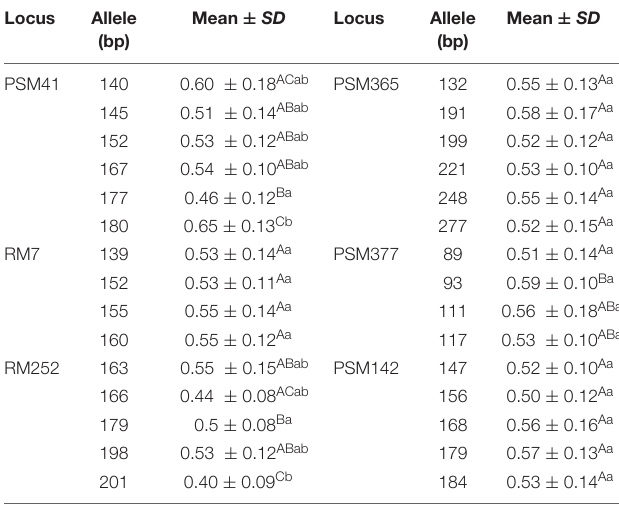
TABLE 3 | Duncan’s test of the Al tolerant performance of rice landraces harboring different alleles of the markers significantly associated with Al